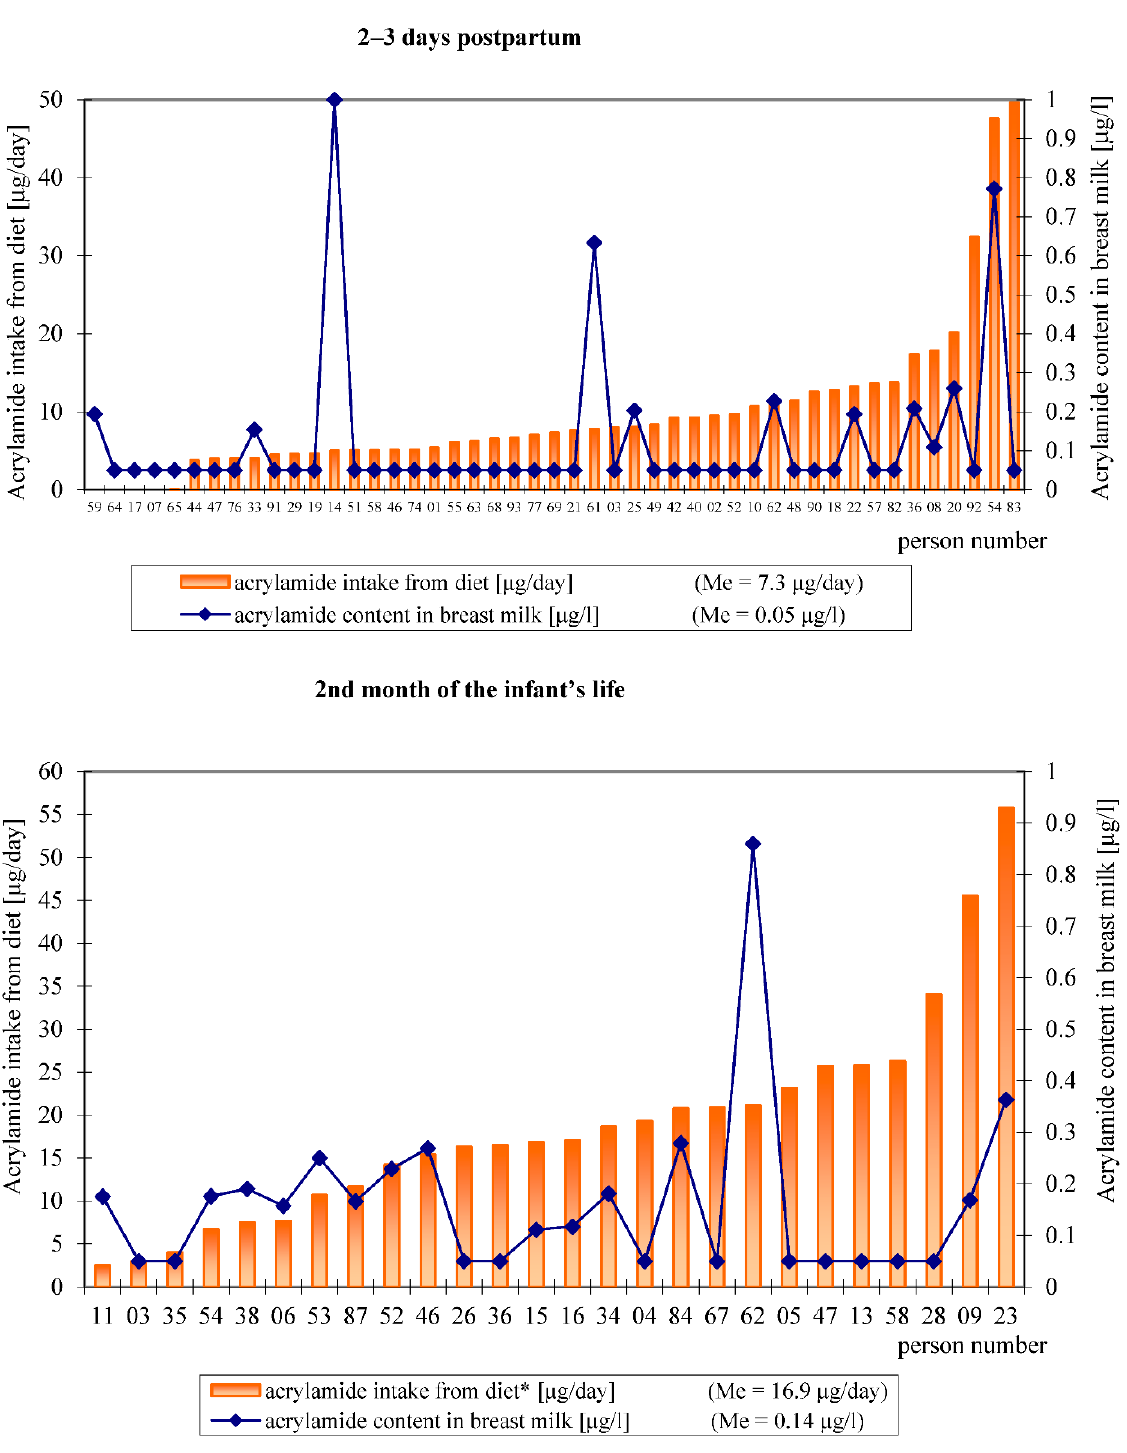
Figure 2. Overview of acrylamide intake by each participant and the acrylamide content in individual breast milk samples. We found positive, although modest and borderline significant, correlation between acrylamide intake from hospital diet by the breastfeeding women (µg/day) and the acryla- mide level in the colostrum (µg/L) (Figure 3). No significant correlation was found be- tween dietary acrylamide intake in the 2nd month of lactation and the acrylamide level in mature milk (r = 0.074; p = 0.72).